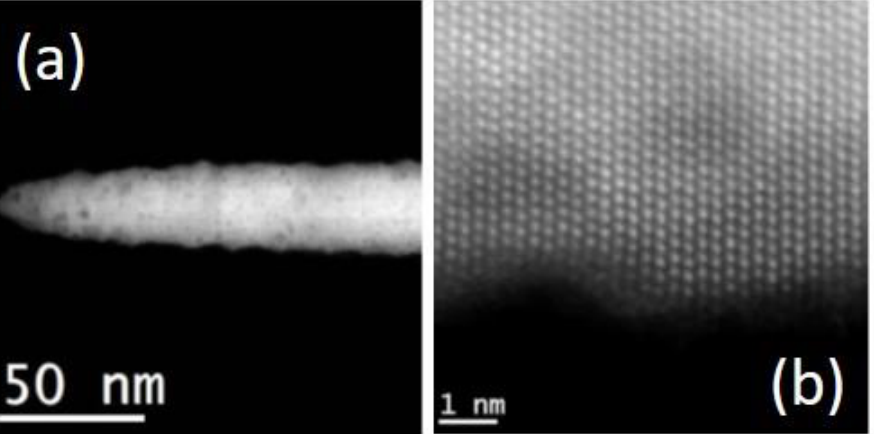
Figure 6. ( a ) TEM HAADF (high-angle annular dark-field) image of an NW implanted using a flu- ence of 1 × 10 15 at/cm 2 and annealed at 1000 °C. ( b ) High-resolution TEM HAADF images of the same NW show a high crystalline quality of the NW core. Adapted with permission from Ref. [45].